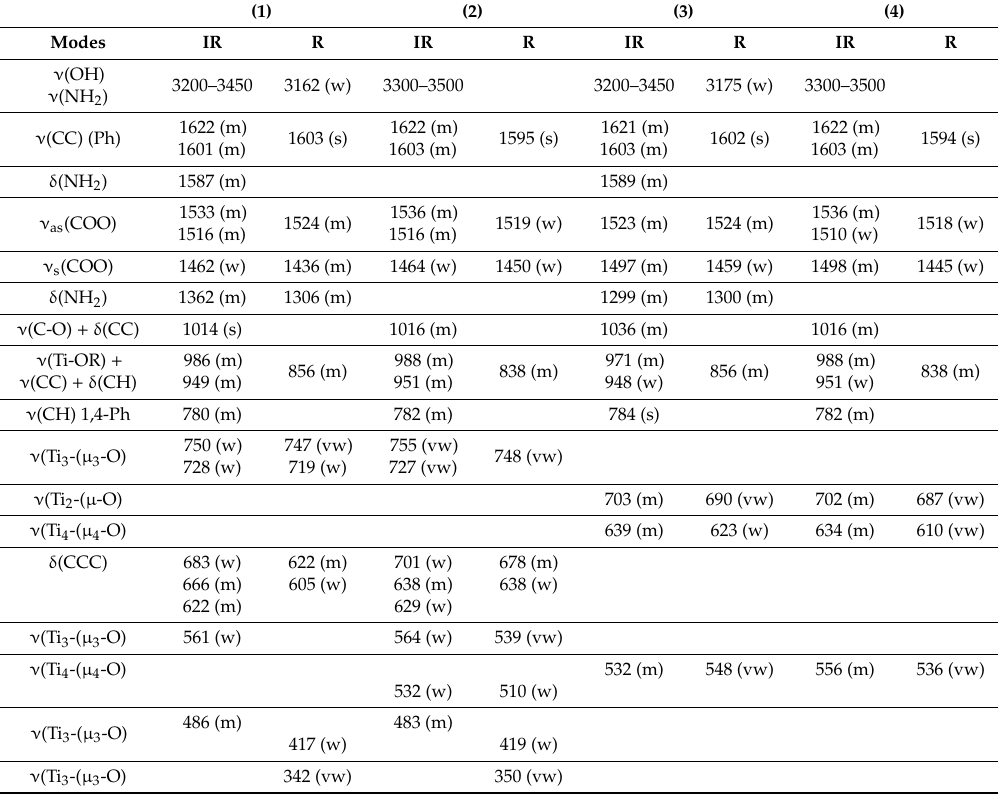
Table 2. Results of the vibrational spectra studies of the ( 1 )–( 3 ) complexes (the band intensity: strong (s), middle (m), weak (w), very weak